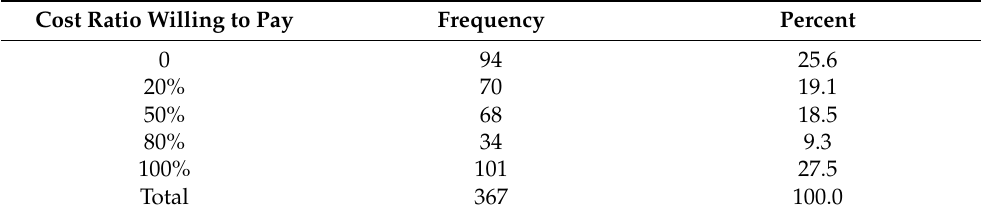
Table 1. Frequency and percentage of respondents willing to pay different cost